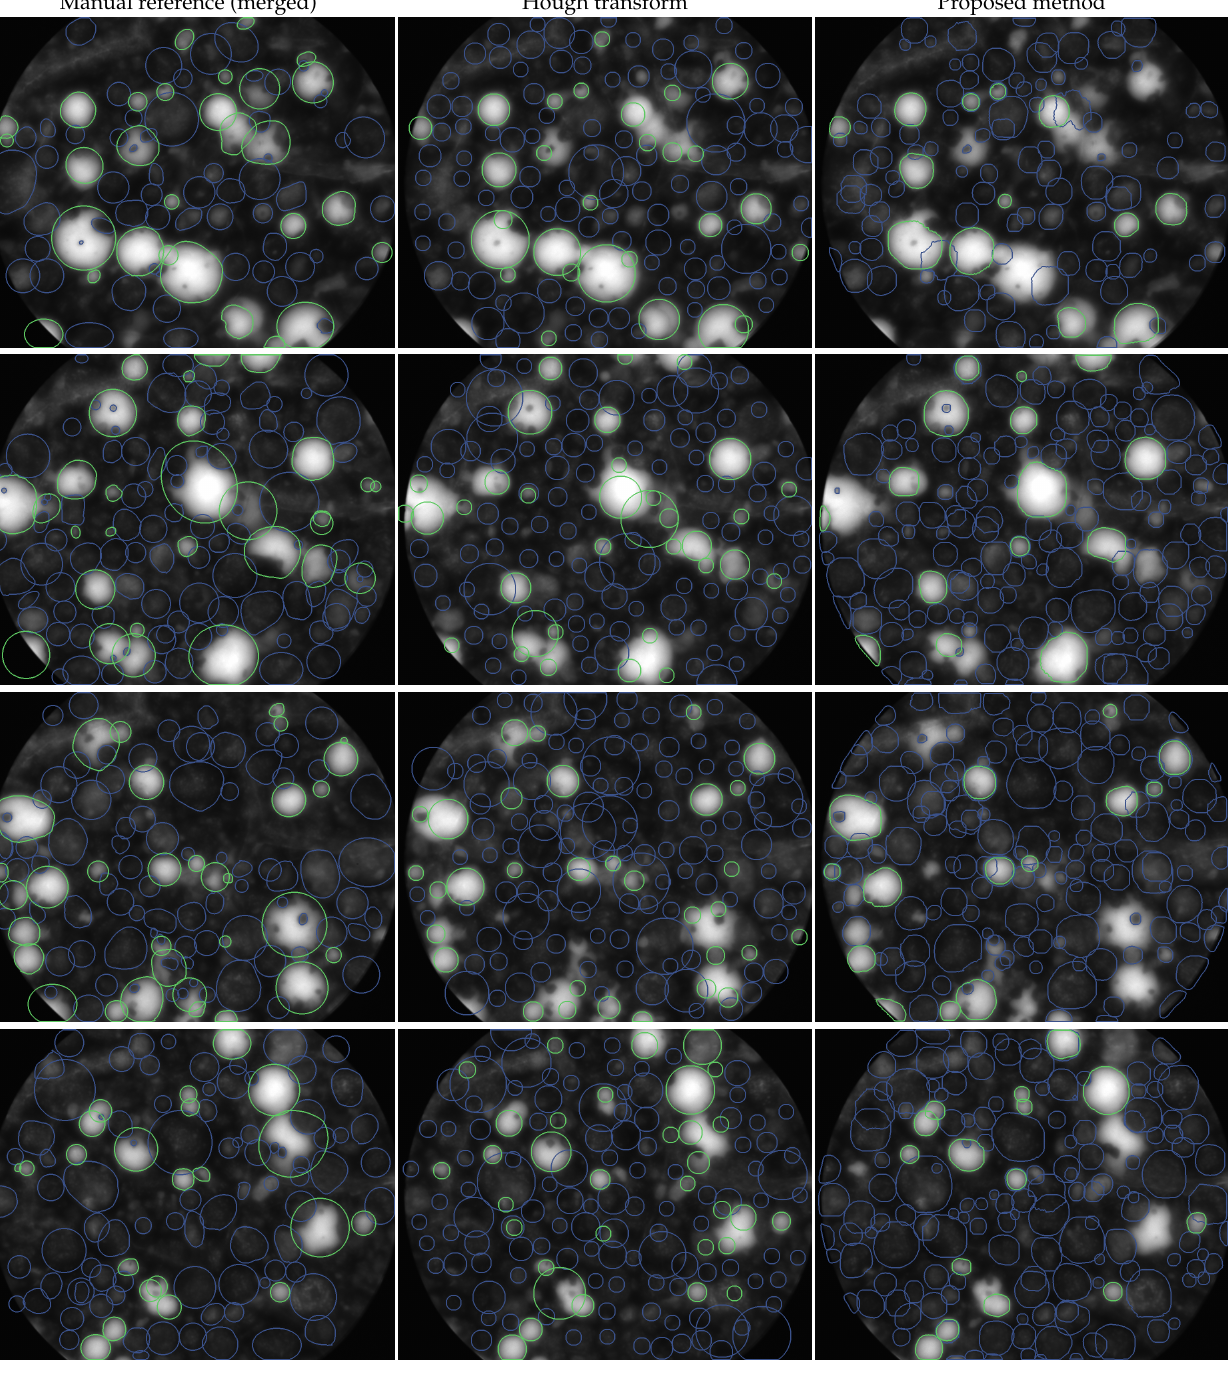
Figure 11. Randomly picked examples of the detection quality of the proposed method and the Hough transform, compared to the merged manual reference.